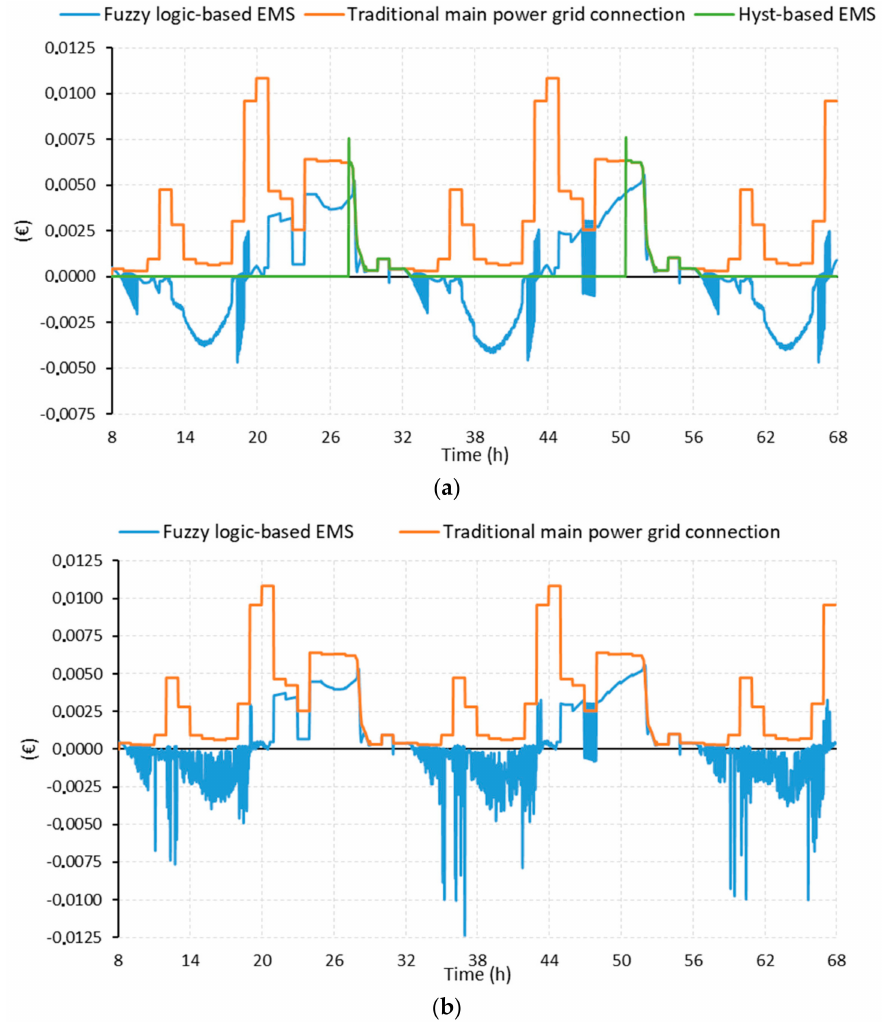
Figure 15. Grid cost for proposed fuzzy logic-based EMS versus traditional main power grid connection and hysteresis-based EMS for ( a ) stable solar profile and ( b ) fluctuating solar